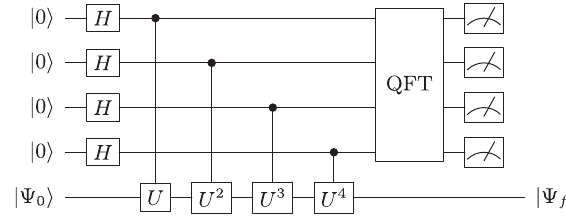
FIG. 1. Overview of the quantum phase estimation algorithm discussed in the main text for k ¼ 4 ancilla qubits. The lowest line in the figure indicates the N qubits used for the physical system. Here, QFT denotes the quantum Fourier transformation. After the measurements, the readout on the k ancilla qubits contains an estimate for the energy, whereas the N qubits for the physical system contain the final state j Ψ of Eq. (12), which is f i an approximation to an eigenstate and can be processed further to obtain measurements on the physical